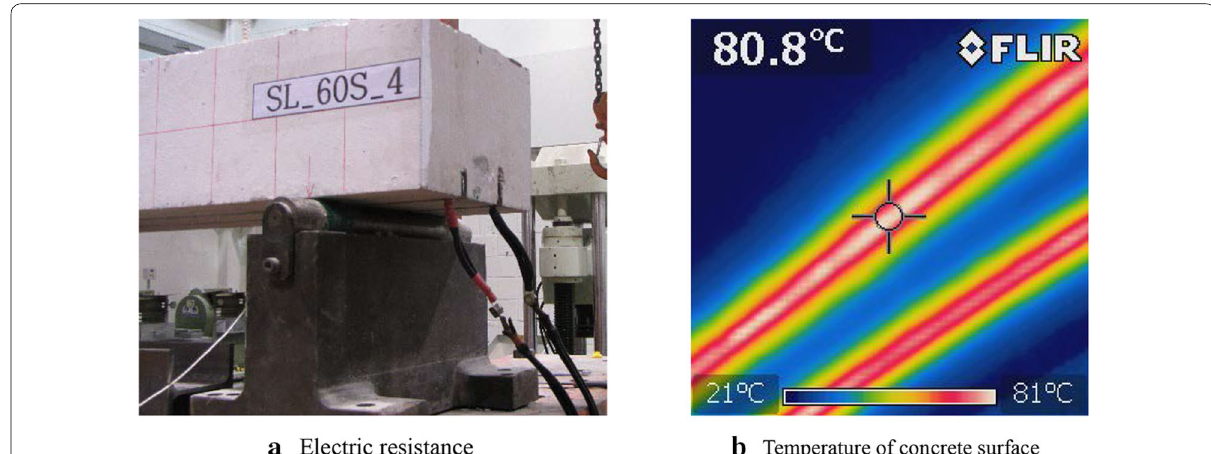
Fig. 8 Activation of embedded Fe-SMA in a concrete beam.